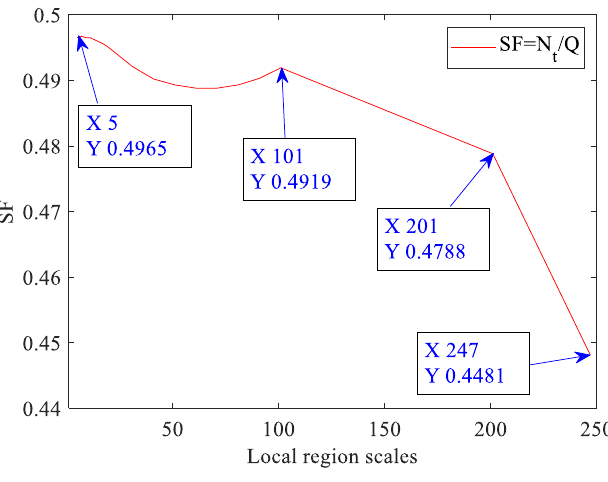
Figure 4. The sparse factor curve. Table 1. The data of the sparse factors and their corresponding regional